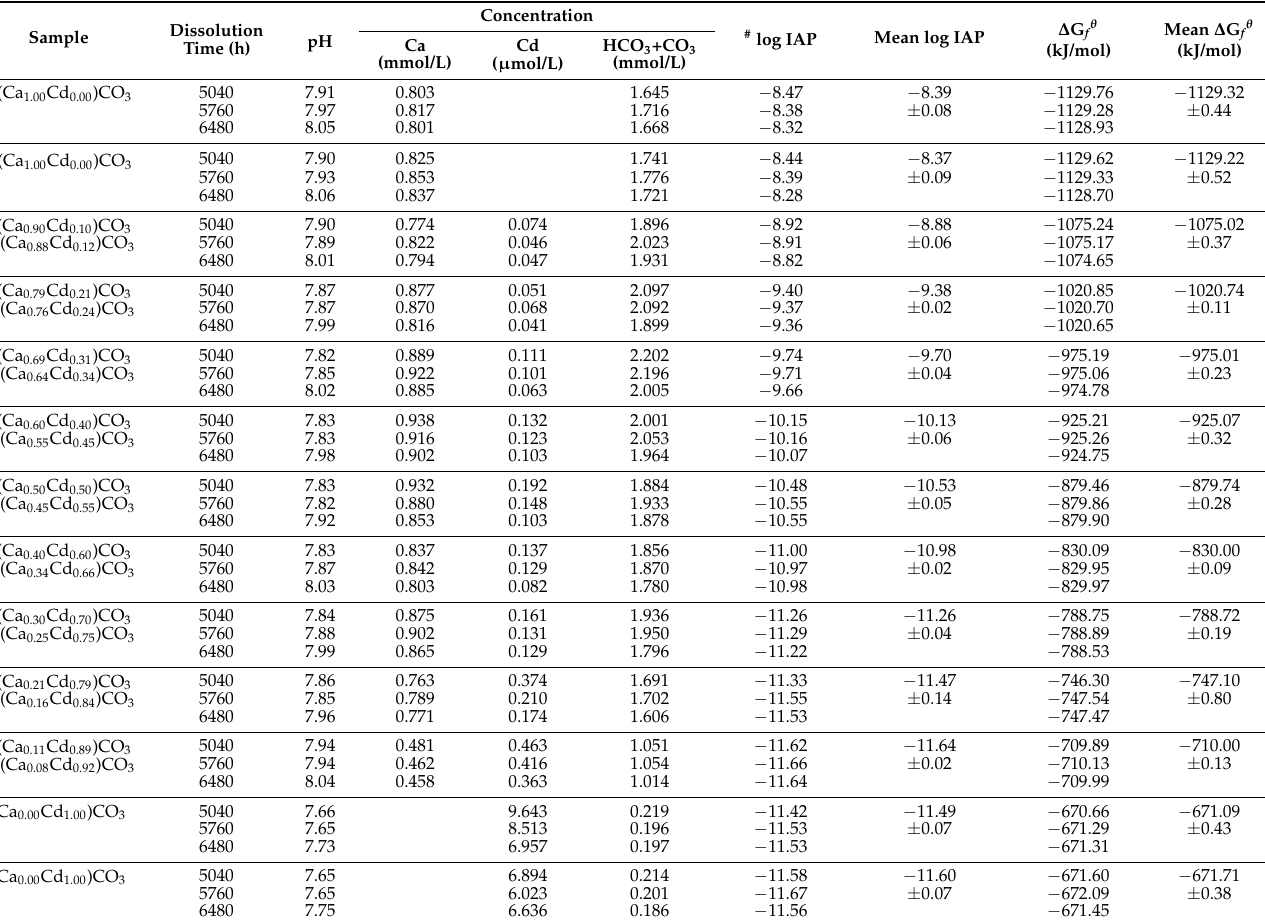
Table 3. Analytical data and solubility for the calcite–otavite solid solutions [(Ca 1 − x Cd x )CO 3 ] in the CO 2 -saturated water at 25 ◦